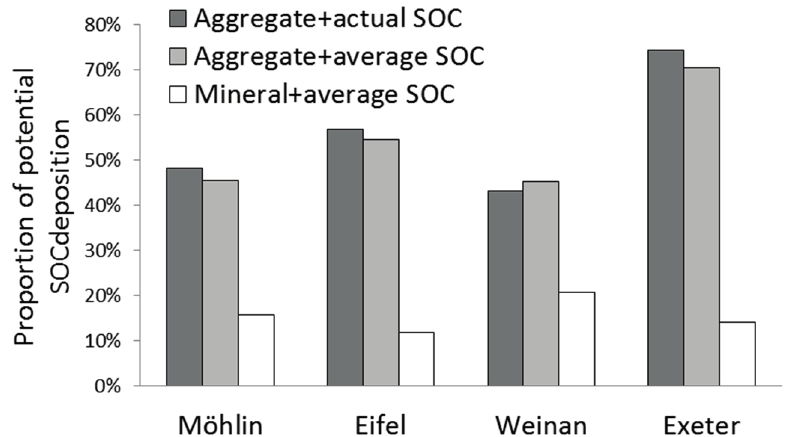
Figure 6. The proportions of potential SOC deposition calculated in different ways. The SOC distribution across EQS fractions and mineral grain fractions were first calculated. The SOC contained in fractions >62 µm was regarded as potentially depositional across landscapes (Starr et al. [34]). “Aggregate+actual” represents the SOC distribution that was calculated by multiplying the SOC concentration of each EQS fraction with their individual weight proportions. “Aggregate+average” represents the SOC distribution was calculated by multiplying the average SOC concentration of bulk soil with weight of each EQS fraction. “Mineral+average” represents the SOC distribution was calculated by multiplying the average SOC concentration of bulk soil with weight of each EQS